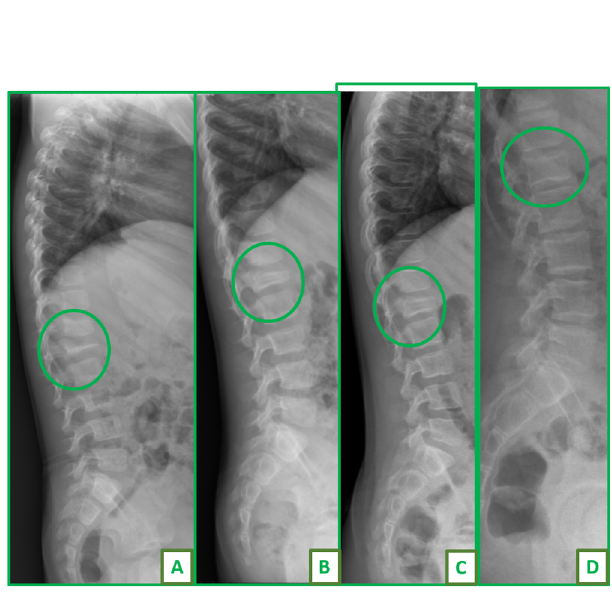
Figure 1. Plain radiograph of a skeletal lesion in the lumbar spine L1 of a 3-year-old boy managed conservatively. (A) Marked fl attening of L1, vertebra plana. (B) Gradual remodeling and restoration of the height after 1-year follow-up. (C) Remodeling after 2 years. (D) Complete restoration of height after 5-year follow-up, child